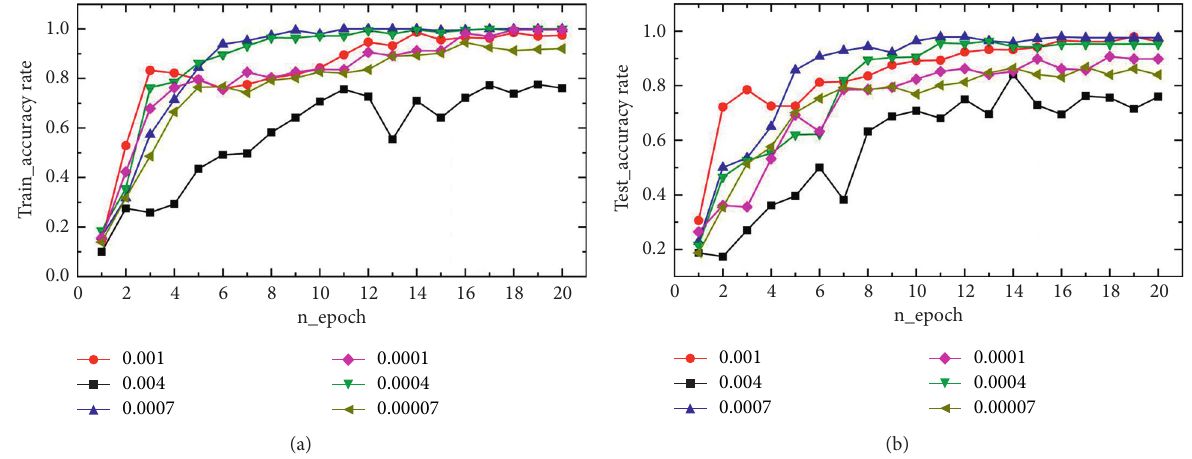
Figure 3: Recognition accuracy curve under different learning